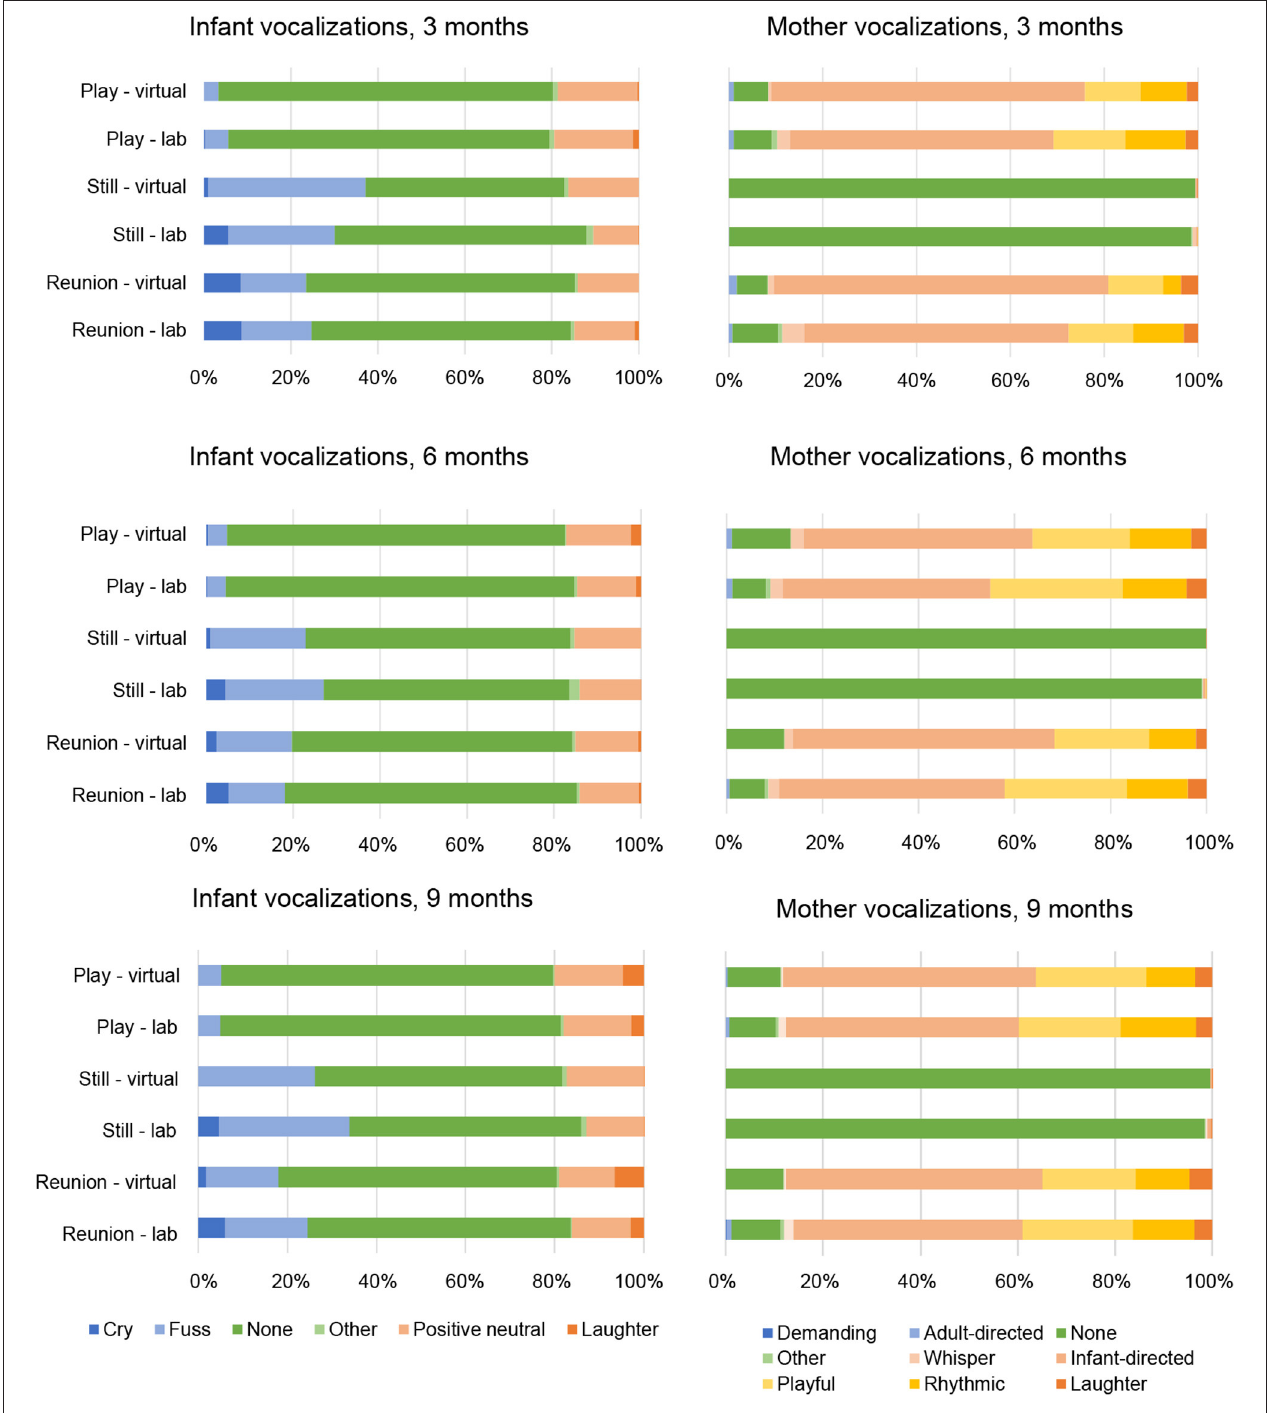
FIGURE 2 | Infant and mother vocalizations by Still Face episode, visit type and time point.